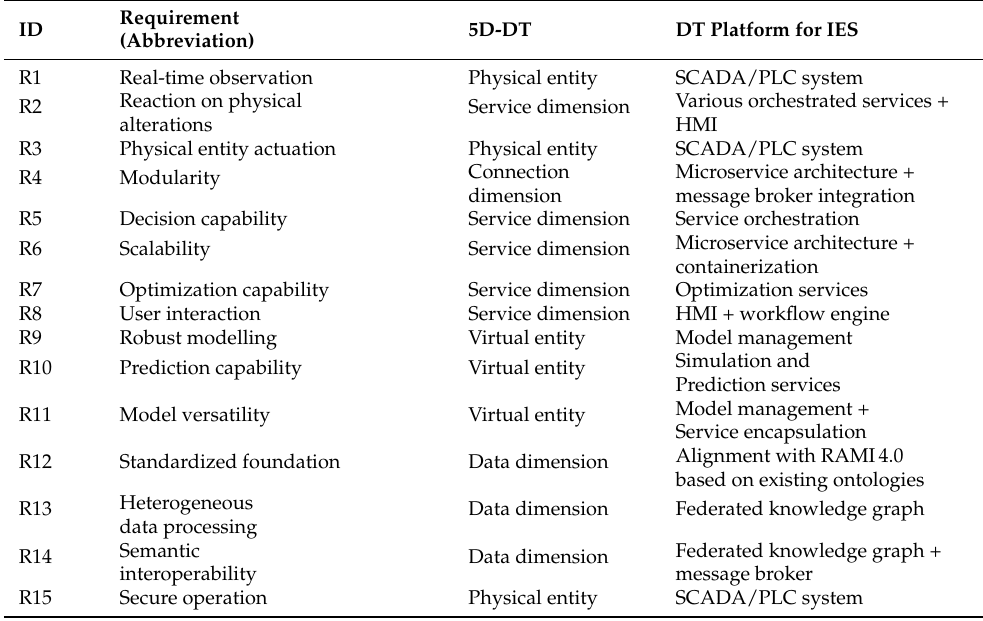
Table 5. Alignment of the identified requirements (see Table 3) supported by implementation aspects of the proposed DT platform. The requirements are listed along with their given IDs, an abbreviation of their description in Table 3, and structured via localization within the five dimensions (5D-DT) of the DT platform for